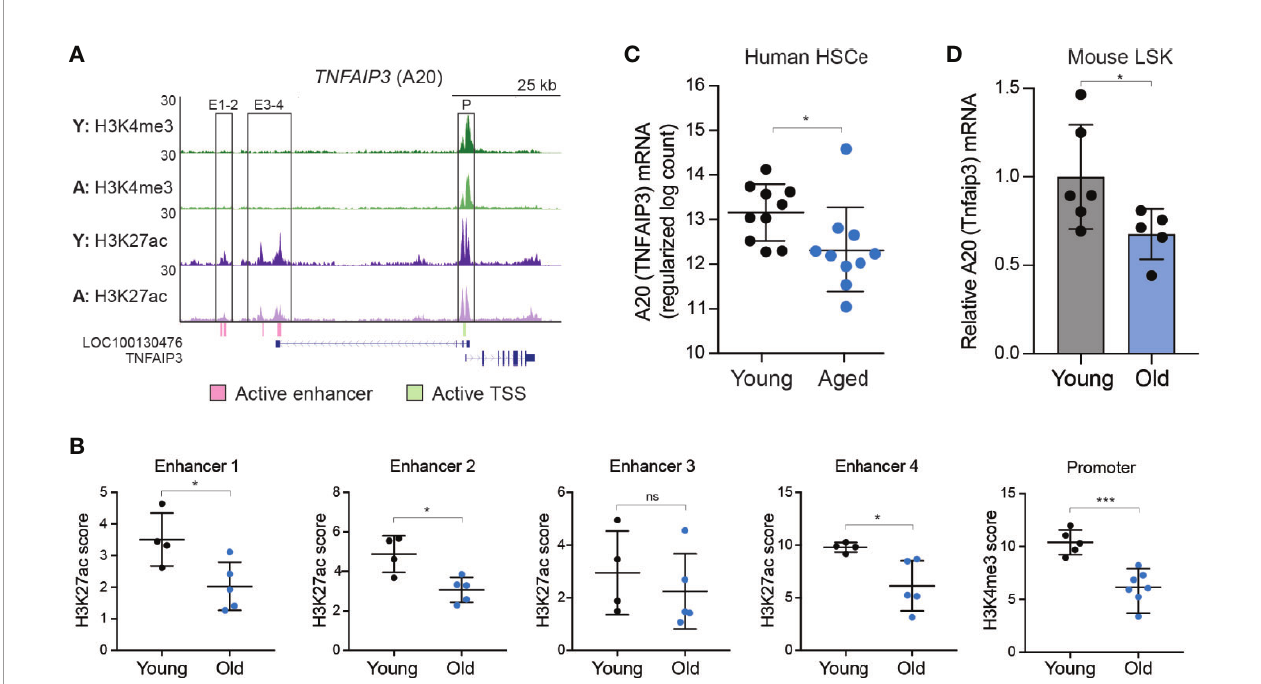
FIGURE 1 | A20 expression is reduced in aged human and mouse HSC. (A) UCSC genome browser tracks of active enhancers within the TNFAIP3/A20 locus that overlap ChIP-seq peaks. Tracks are of pooled replicates for each age group, normalized to reads per million and to the corresponding input. Y, young; A, aged. (B) Quanti fi cation of the peak height from Figure 1A for H3K27ac within enhancers (E) 1-4 or H3K4me3 within the promoter (P). *P < 0.05; ***P < 0.001. (C) RNA- seq gene expression analysis of TNFAIP3 (A20) in young (n = 10) and aged (n = 10) HSCe (Lineage - CD34 + CD38 - ). (D) Tnfaip3 (A20) mRNA expression in young and old LSK BM cells by qRT-PCR (n = 6 and 5 per group, respectively). *P < 0.05. Data are represented as mean ± standard